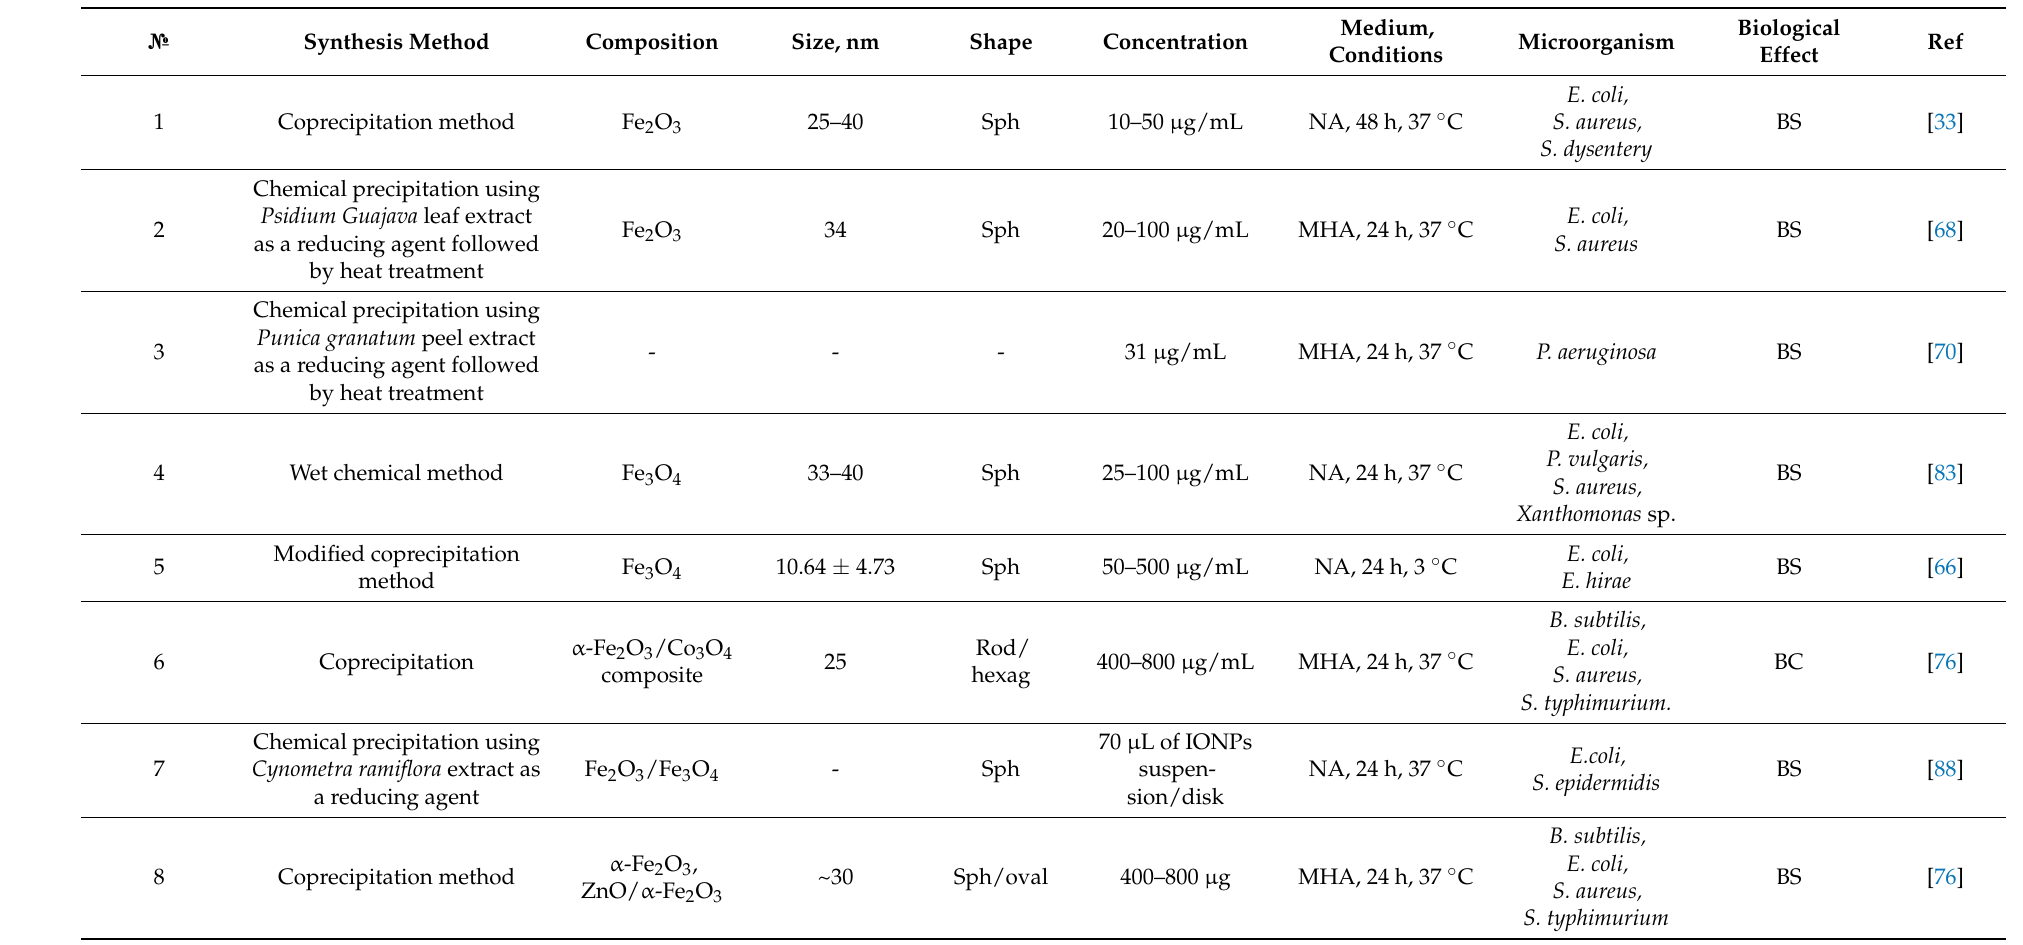
Table 2. Parameters of the nanoparticles reported in the